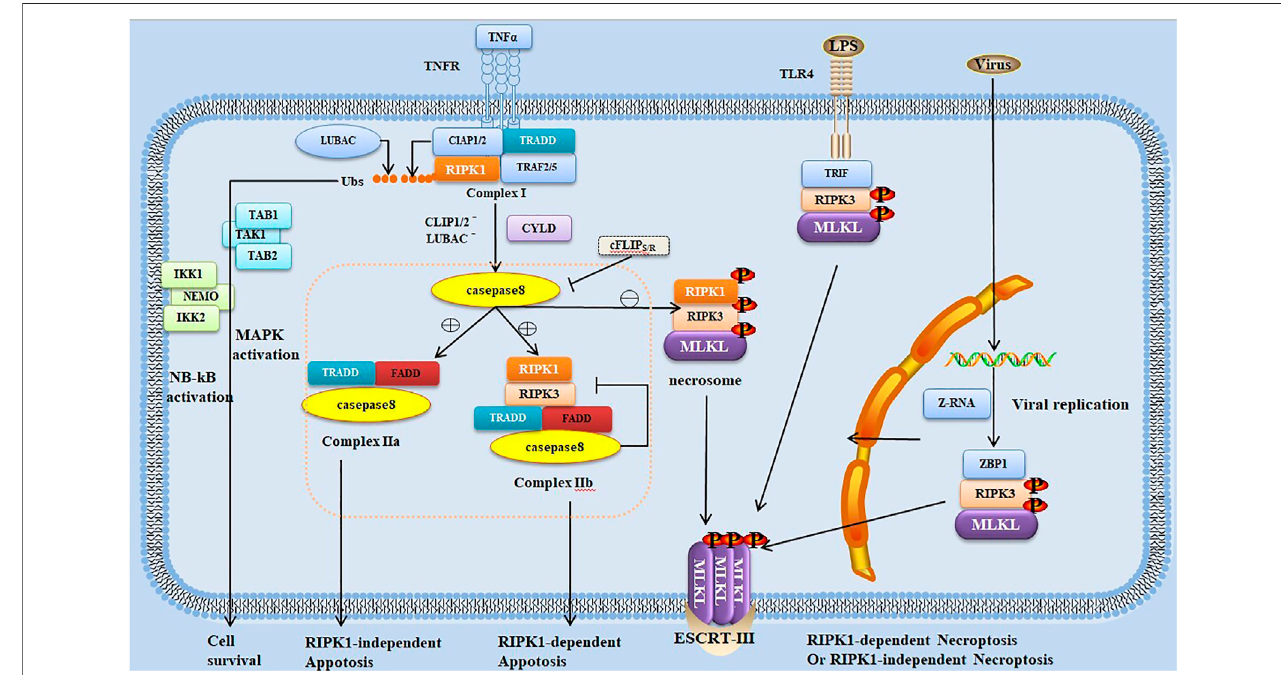
FIGURE1| Triggerandregulationofsignaltransductionpathways innecroptosisandapoptosis.Necroptosistypicallyoccursasaconsequenceofthestimulation of tumor necrosis factor receptor (TNFR) 1 by TNF, leading to the formation of receptor-bound complex I such as TNFR1-associated DD (TRADD), receptor-interacting protein (RIP) kinase (RIPK) 1, TNF-associated factor 2/5 (TRAF2/TRAF5), cellular inhibitor of apoptosis proteins (cIAPs), and linear ubiquitin chain assembly complex (LUBAC).RIPK1ubiquitinationbyLUBACorcIAPsresultsintherecruitmentofI- κ Bkinase(IKK)complex(includingIKK1,IKK2,andthenuclearfactor-kappaB(NF- κ B) essential modulator [NEMO]) and transforming growth factor- β -activated kinase 1 (TAK1)-binding protein (TAB) complex, leading to the activation of mitogen- activated protein kinase and NF- κ B for cell survival. Cylindromatosis (CYLD) and A20 deubiquitinate RIPK1, which is released from complex I, leading to the transition from complex I to cytosolic complex II. The binding of TRADD – Fas-associated death domain protein (FADD) – caspase-8, one complex called complex IIa, triggers RIPK1-independent apoptosis, whereas the other complex IIb (comprising RIPK1, RIPK3, FADD, and caspase-8) triggers RIPK1-dependent apoptosis. Moreover, RIPK1can inhibit FADD – caspase-8-dependent apoptosis. Caspase-8 can be inhibited by c-FLIP asaresult of heterodimerizationbetweenc-FLIPS and procaspase-8. With the reduction, blockage, or absence of cIAPs or caspase-8, the necrosome (comprising RIPK1, RIPK3, and MLKL) is formed, which is the binding of activated